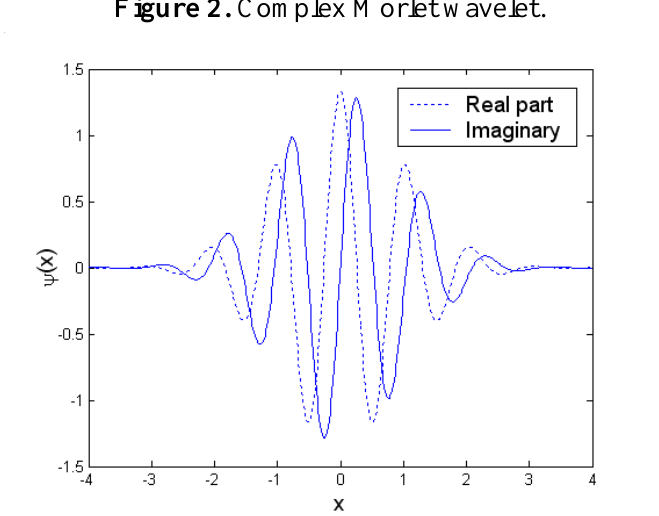
Figure 2. Complex Morlet